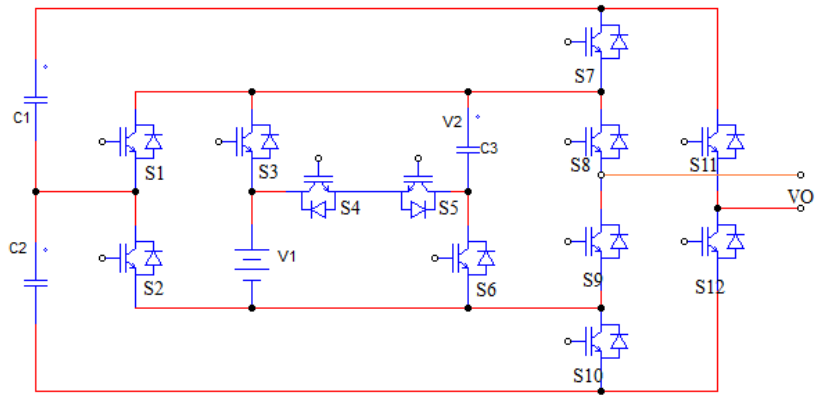
Figure 9. 12-switch, 9-level topology [58].